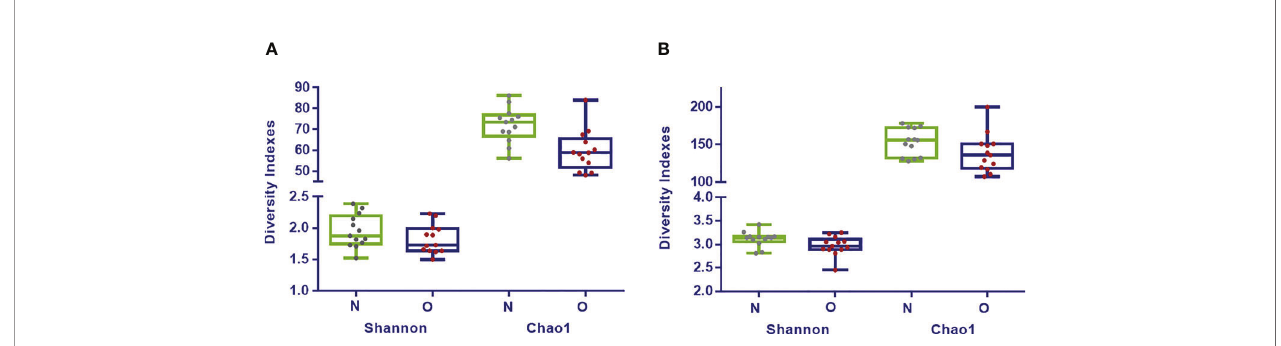
FIGURE 1 | Diversity Indexes Shannon and Chao1 in fecal samples from normoweight (N, ) and obese (O, ) individuals at family (A) and genus (B) taxonomical levels. The median, minimum, and maximum values are